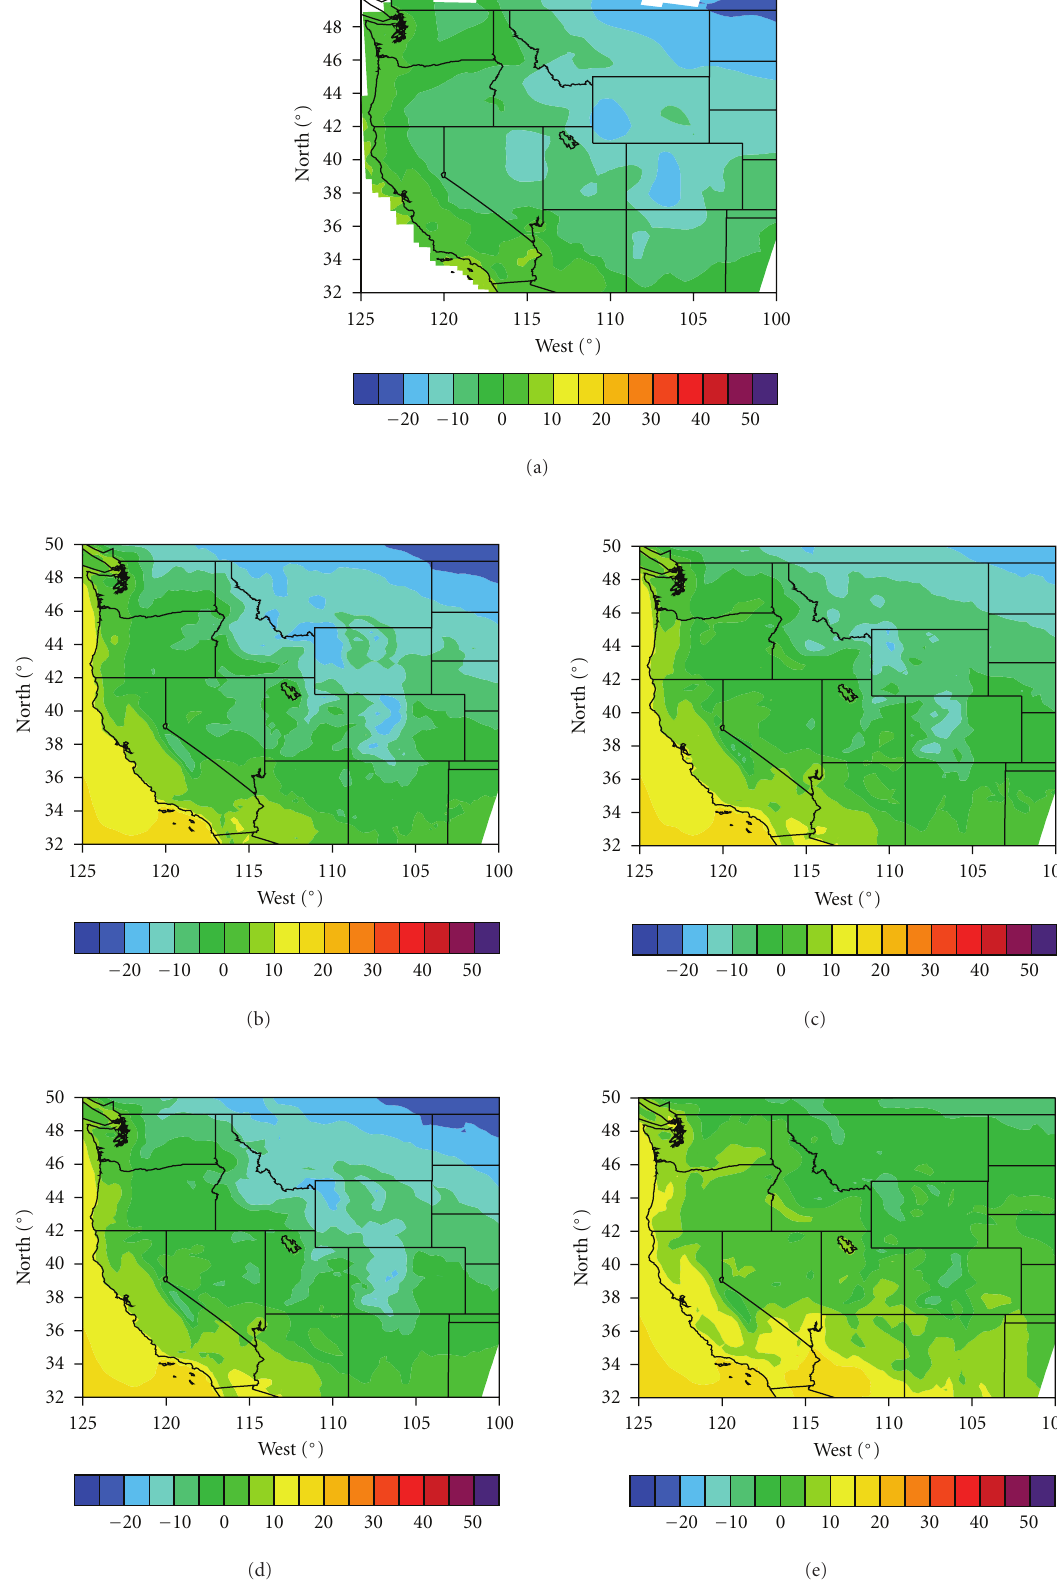
Figure 5: The geographic distribution of observed and WRF-simulated winter (December, January, and February) daily minimum temperature (Unit: ◦ C). (a) Observations; (b) CLM3; (c) Noah; (d) RUC; (e)